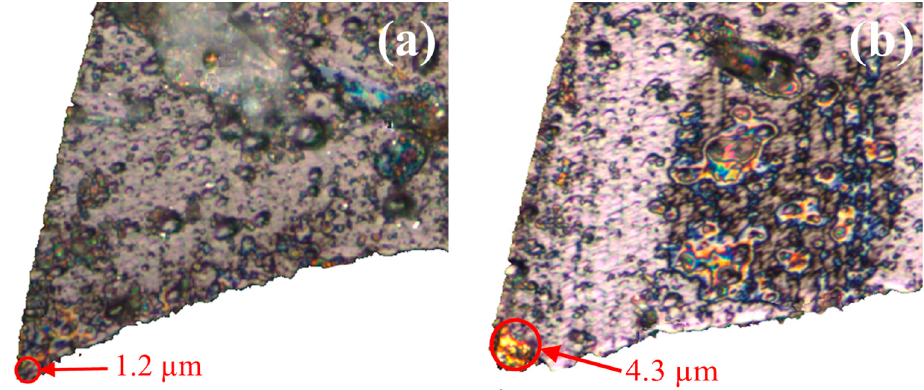
Figure 11. Optical images of the ( a ) new tool and ( b ) worn tool.